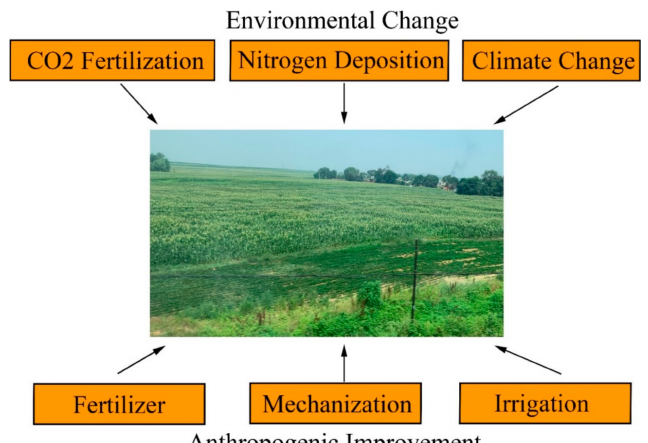
Figure 7. The influencing factors of cropland.